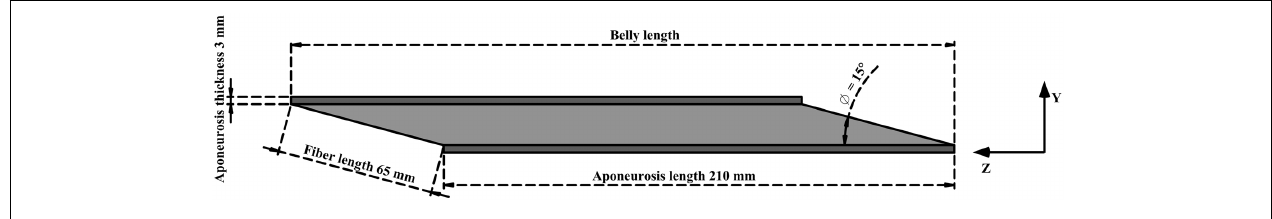
FIGURE 1 | Simplified geometry of lateral gastrocnemius. Aponeurosis tissue in dark gray and muscle tissue in light gray. The origin of the muscle coordinate system was set to the bottom right corner of the deep aponeurosis, and the axes were aligned with x, width; y, thickness, z, belly length.